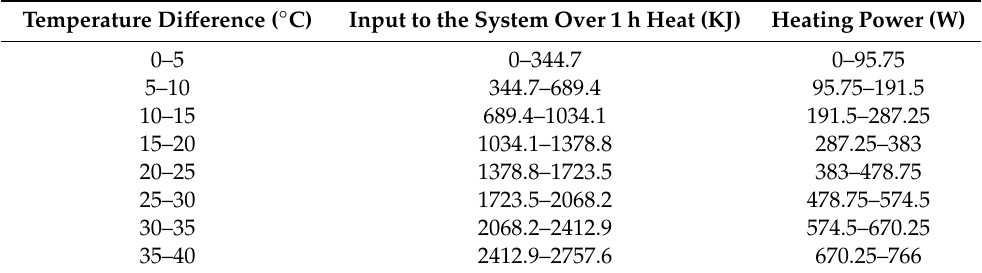
Table 3. Corresponding heating power table under di ff erent temperature di ff erences.